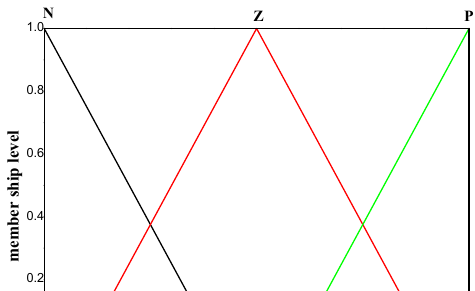
Table 1. Fuzzy PI Rule Table.